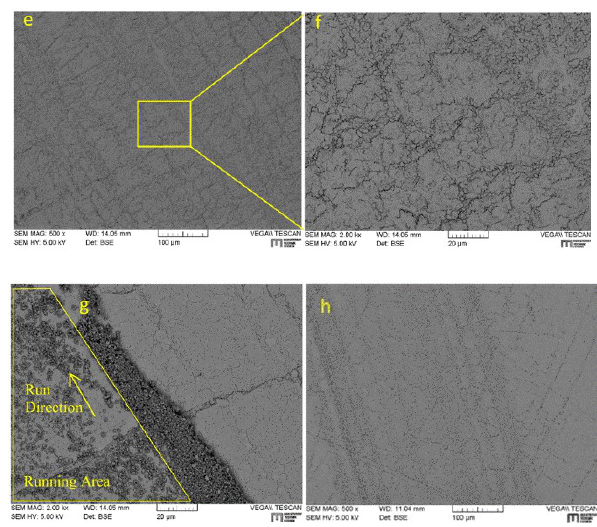
Figure 10. Scanning electron microscope (SEM) micrographs: wear track of 300 nm Hybrid_A coated FKM ( a ), 300 nm MoS 2 coated FKM ( c ), 300 nm DLC coated TPU ( e , g ), and 300 nm MoS 2 coated TPU